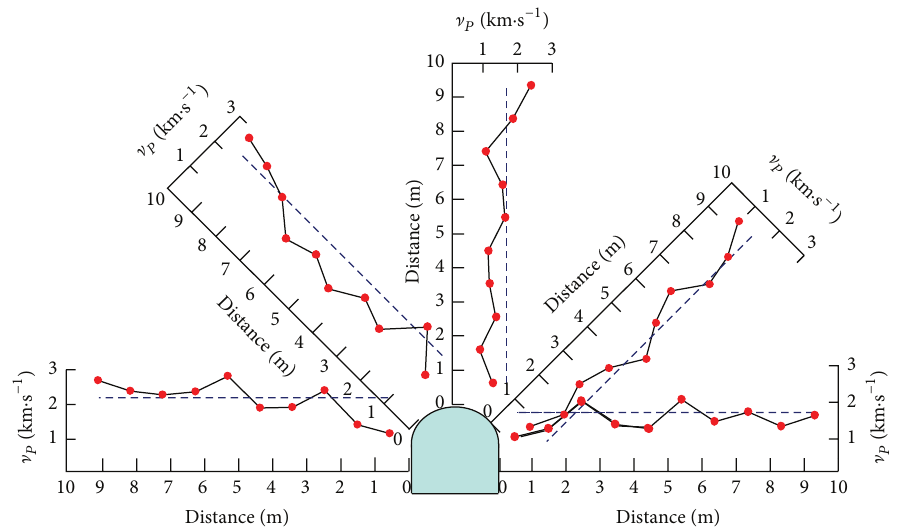
Figure 5: Relations of acoustic-wave velocities ( ] 𝑃 ) and the distance of boreholes.